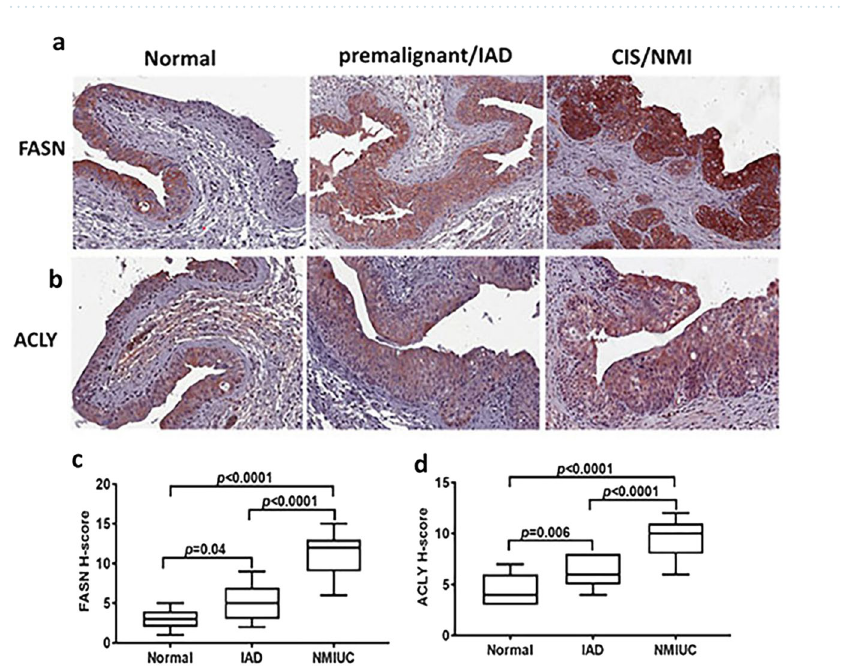
Figure 7. The expression FASN and ACLY proteins in bladder lesions. ( a , b ) IHC staining of FASN and ACLY in normal, premalignant and NMI lesions (200 × magnifications). ( c , d ) Box plots of the H-scores of the intensity and frequency of the immuno-staining. p -values were determined by one-way ANOVA with multiple